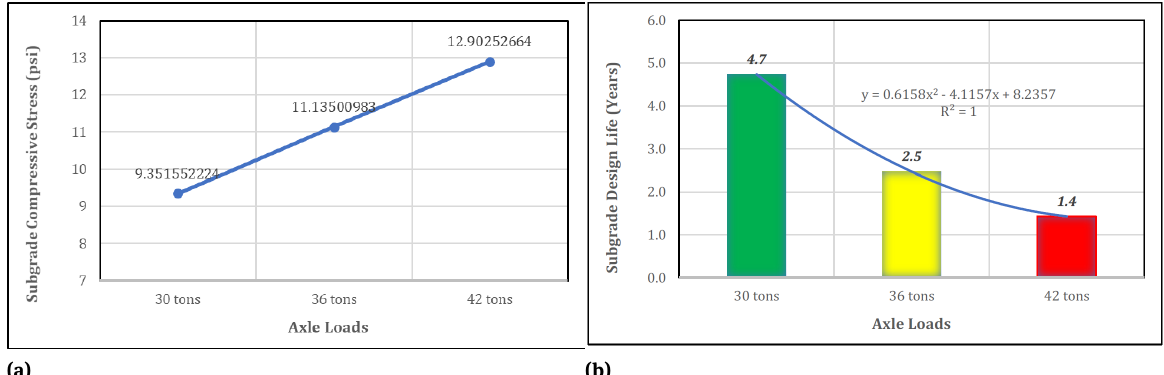
Figure 12: Axle loads effect on subgrade compressive stress (a) and on subgrade service life (b) in granular rail